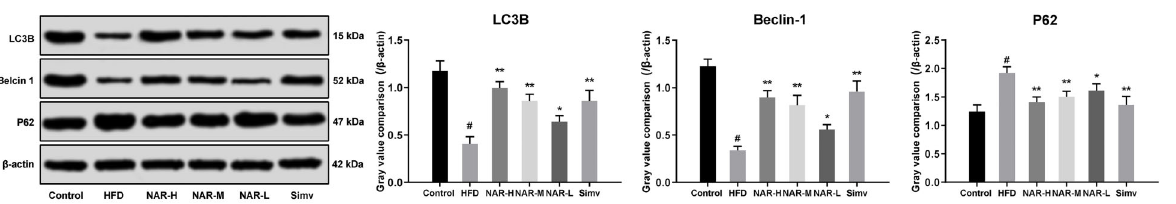
Figure 5. NAR enhanced expression of autophagy-related proteins in the aortic plaque in HFD-induced atherosclerosis ApoE – / – mice. Protein expression of cell autophagy-related protein was detected using western blot analysis, n=3. Data are reported as mean ± SD. # P o 0.01, *P o 0.05, compared to the control group; **P o 0.01, compared to the HFD group; n=5 (ANOVA). NAR: naringenin: high (H), medium (M), low (L); HFD: high-fat-diet; ApoE – / – : apolipoprotein E-knockout; Simv: simvastatin; LC3B: protein 1 light chain